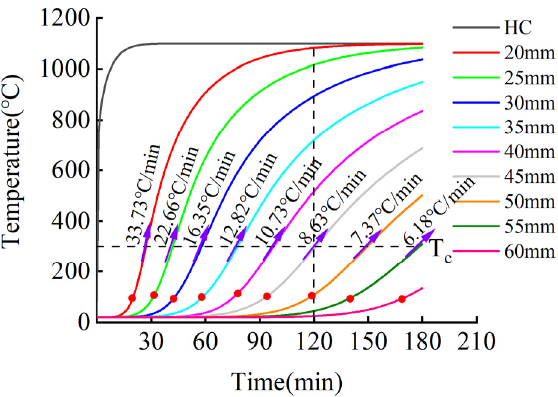
Figure 19. Temperature ‐ time curve of CFRP tendons protected with high ‐ silica needle felt.